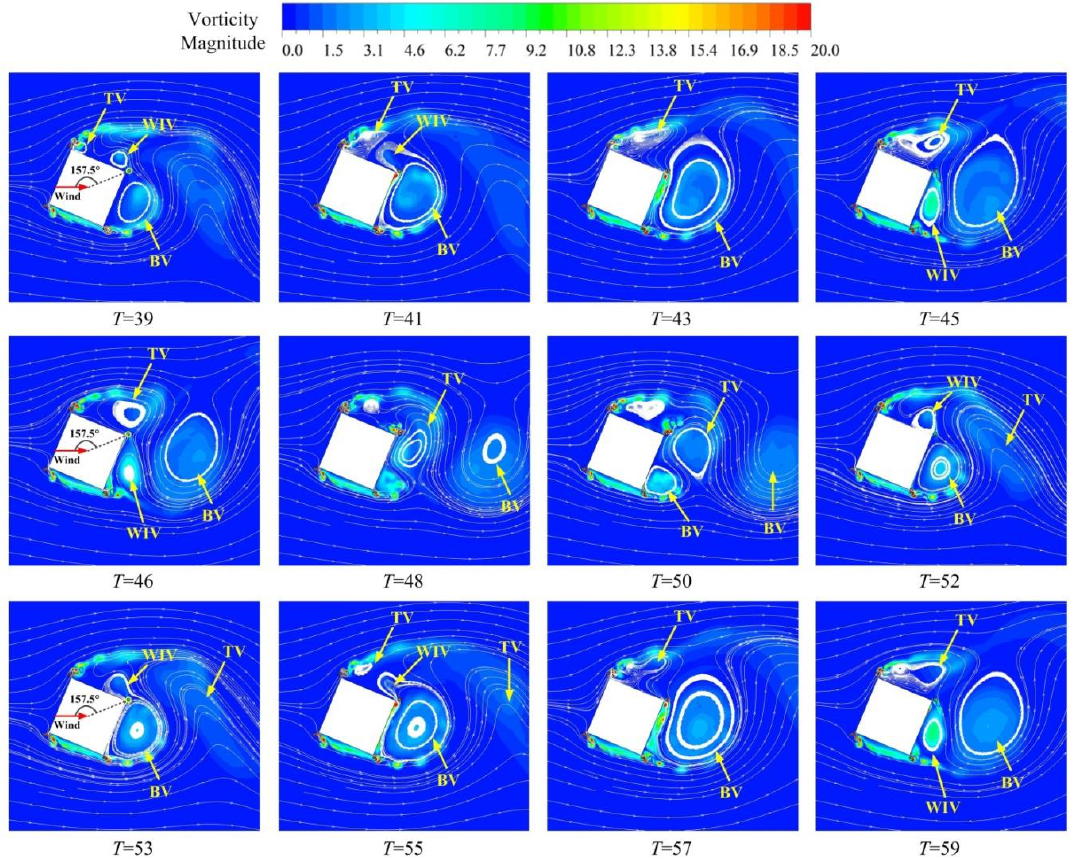
Figure 24. Contours of vorticity and streamlines around the building at φ = 157.5°.